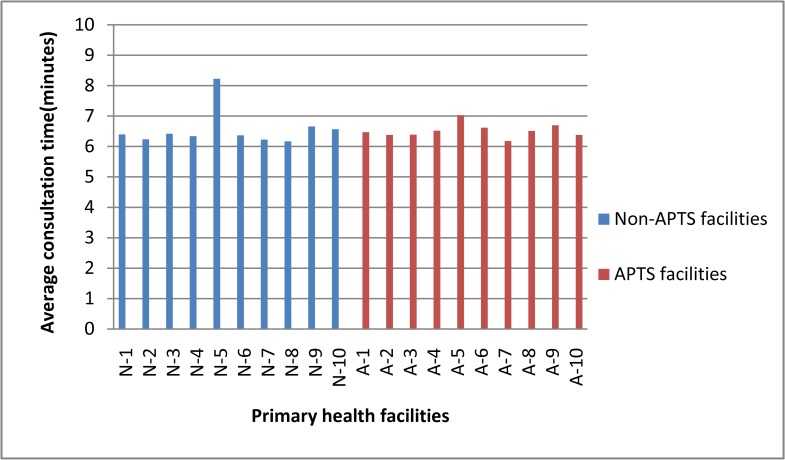
Average consultation time in minutes between individual APTS and non-APTS facilities.N-Non-APTS A-APTS.